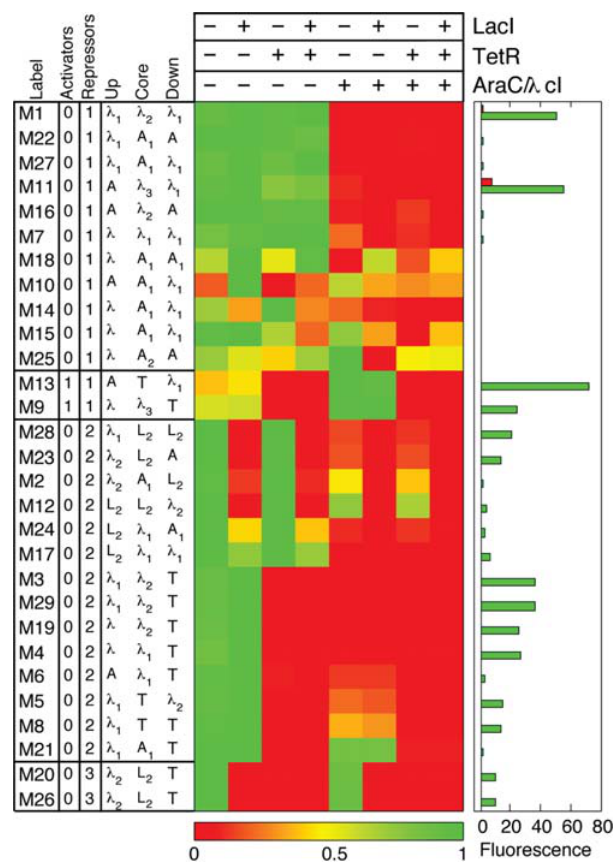
Figure 6. Randomly assembled promoter library. Color chart of 29 promoters created through random assembly (same plotting conventions as in Fig. 3). There are three sets of identical sequences (M14/M15, M3/M29, and M20/M26), leaving 26 unique sequences all different from the forward-designed sequences shown in Fig. 3. Promoters are grouped according to effective behavior of components, ordered from the cleanest implementation of the logic to the fuzziest.